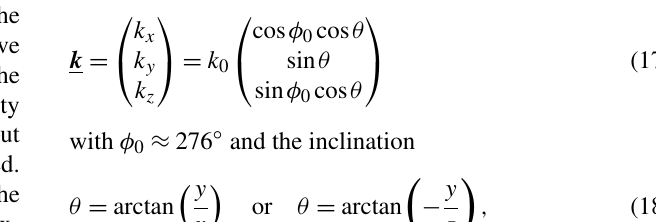
Figure 7. Illustration of the phase structure in SW. The wave (cid:57) Eq. (19) with k ⊥ j and zy (right)